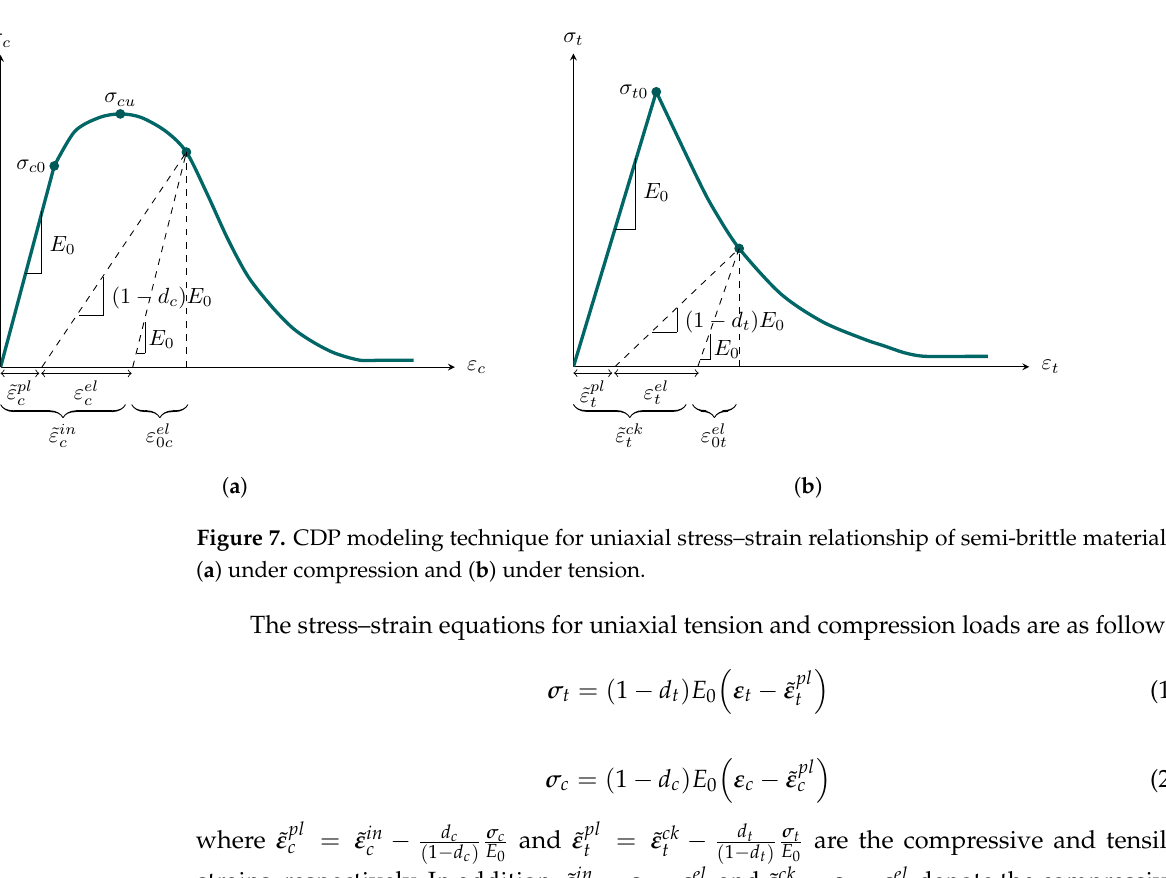
Figure 6. Interactions between different components of the computational model: ( a ) the masonry blocks and mortar junctions and ( b ) the masonry prism and SMA stripes.